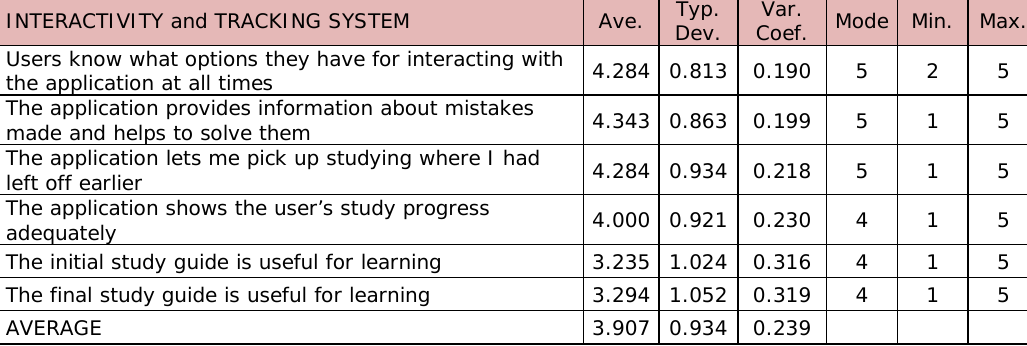
Table 2. “Assessment of interactivity and Tracking